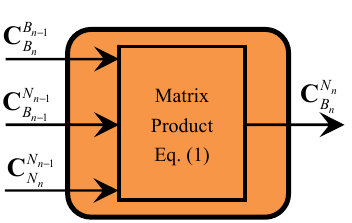
Figure 6. Diagram of module M4.